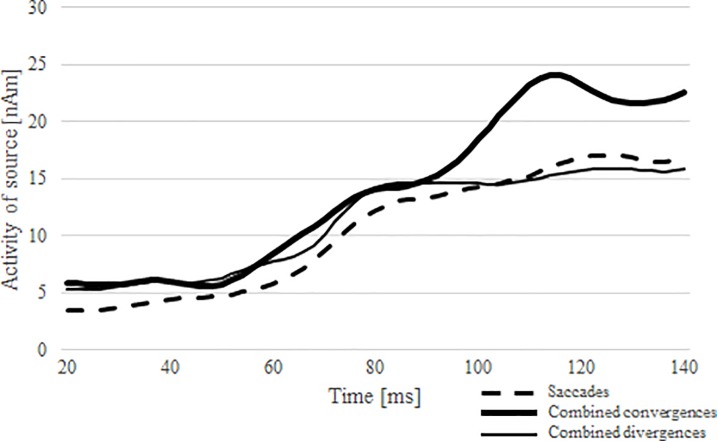
Contralateral source activity elicited by eye movement preparation in occipital source RS2.Source waveforms were prepared per participant by calculating the RMS (root mean square) for each condition within a regional source. Then, the averages of all individuals per condition and contralateral activity were computed. Finally, the result is shown in the figure. The obtained averages for each type of eye movement were used for statistical analyses.